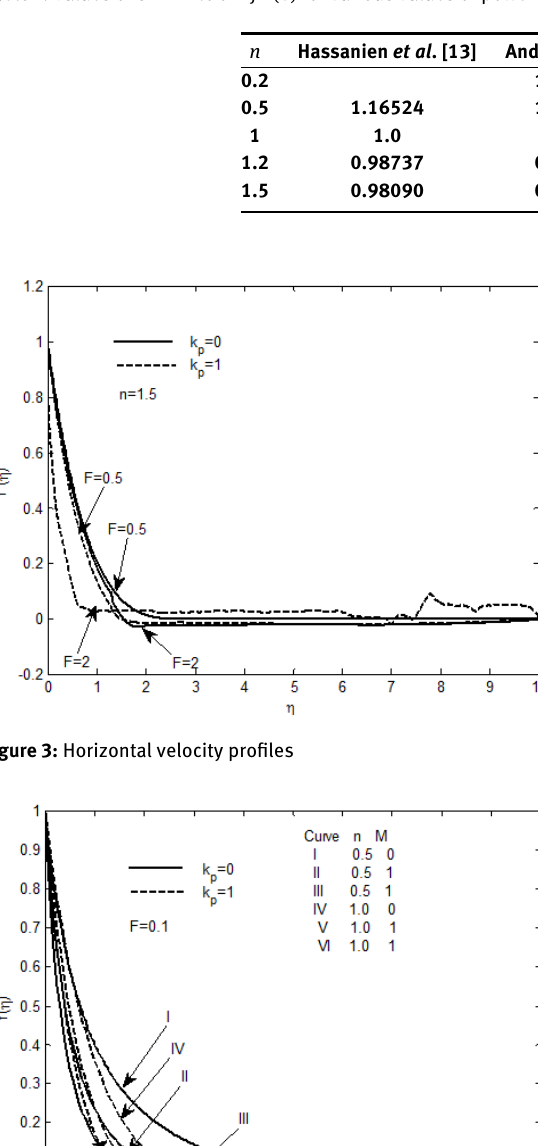
Table 1: Values of skin friction − f ′′ (0) for various values of power-law index n with M = 0